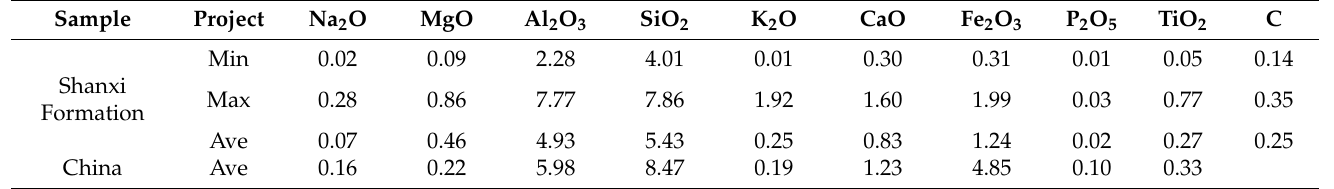
Table 3. Content range of major oxides in the coal of the Shanxi Formation in Huainan